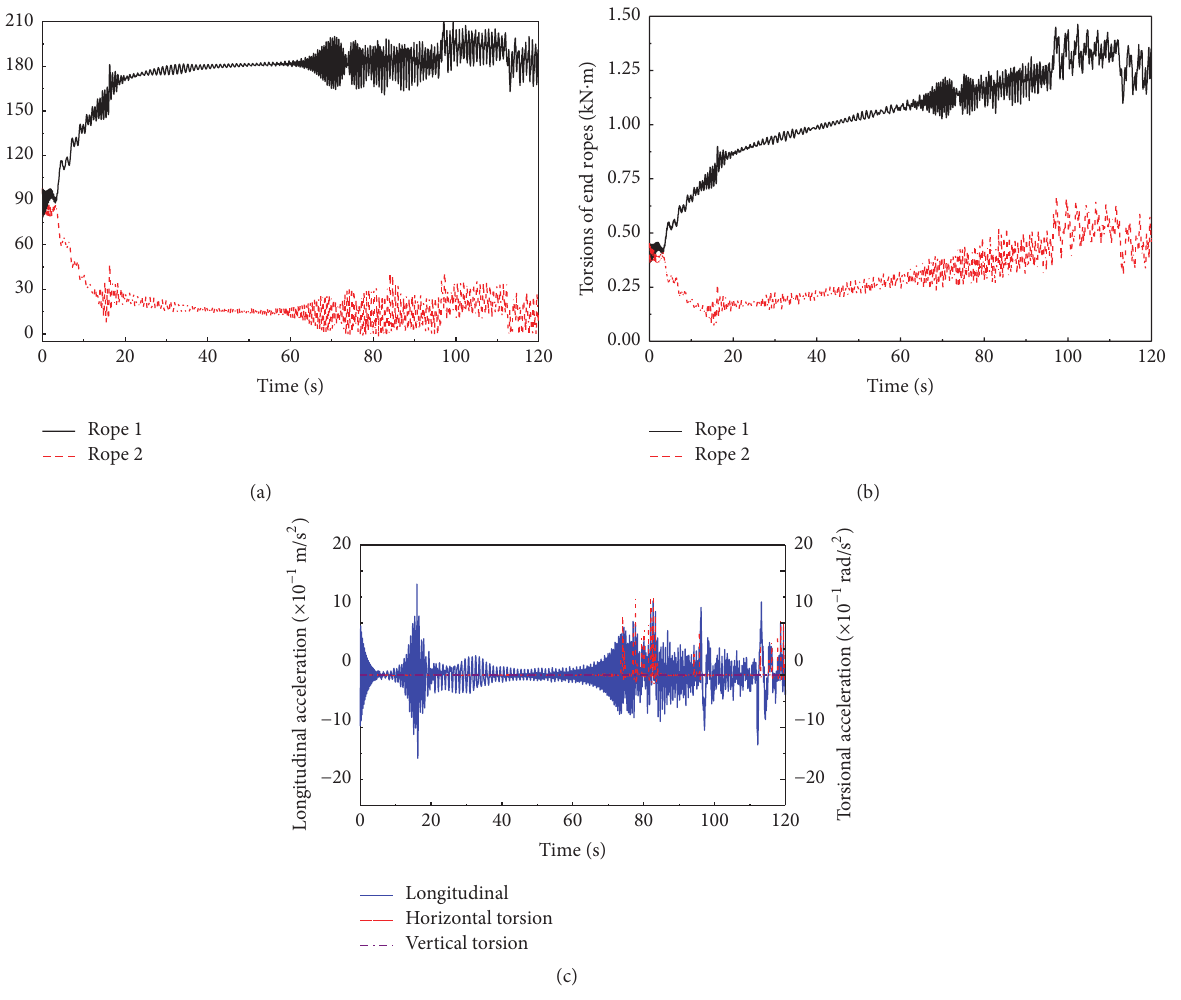
Figure 6: (a) Tensions, (b) torsions of the end ropes, and (c) accelerations of conveyance, calculated using 𝜉 = 0.001 .